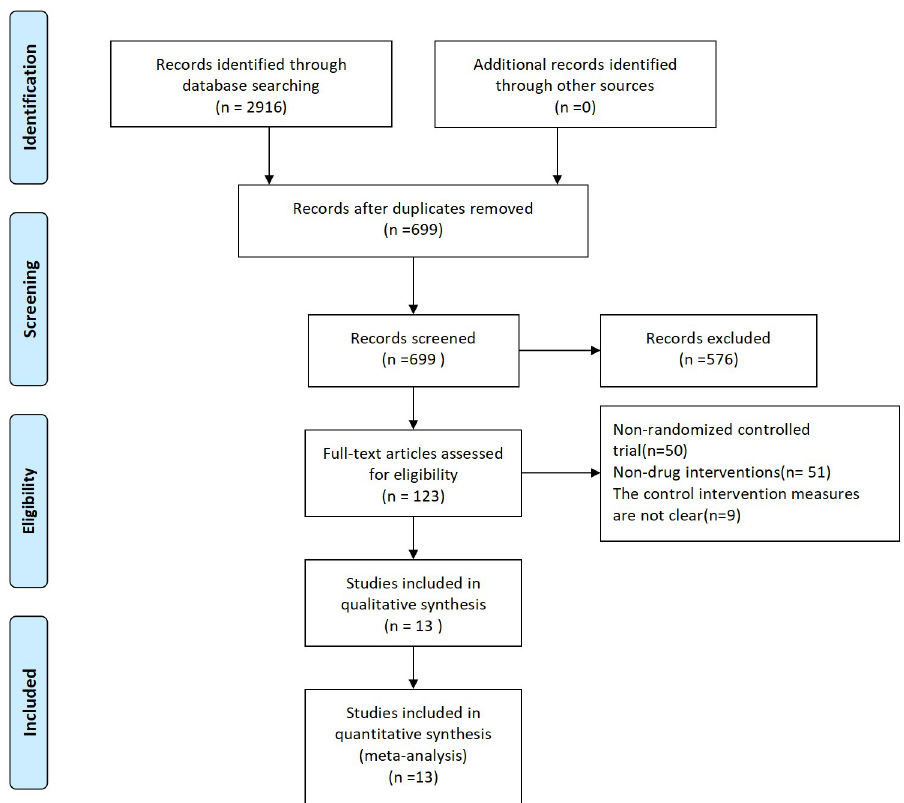
Fig 1. Flow chart of literature